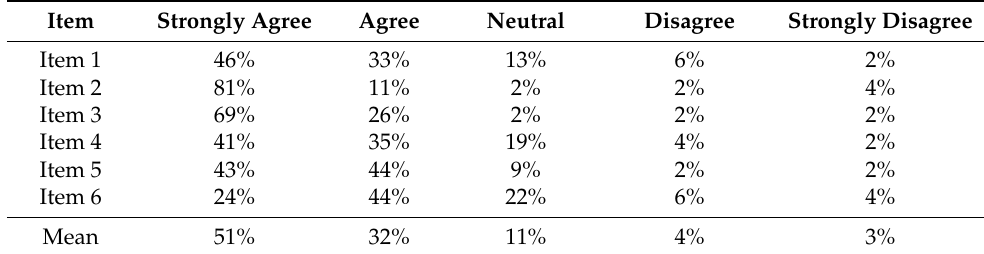
Figure 1. Perceived importance of developing cross-linguistic knowledge and skills by item and number of participants. Table 13. Perceived importance of developing cross-linguistic knowledge and skills: agreement rates.